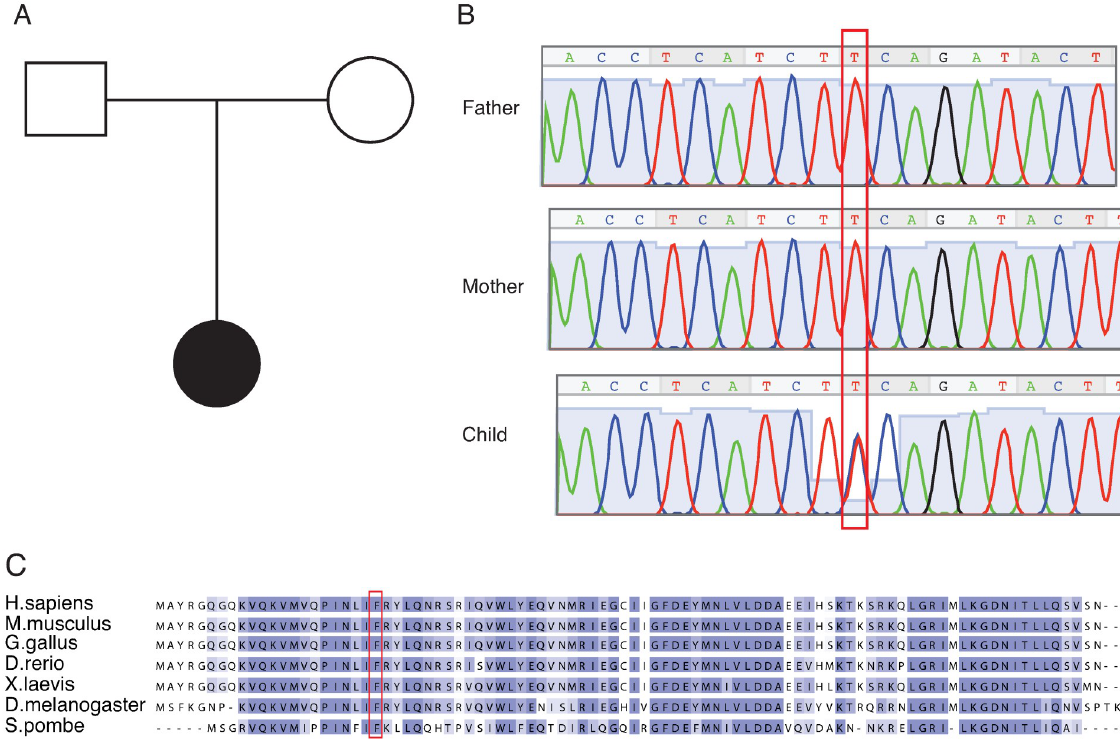
Fig 1. Identification of potential causative mutation by whole exome sequencing. (A), Family pedigree. Filled symbol indicates individual suffering from non-syndromal primary microcephaly and intellectual disability. (B), Traditional Sanger sequencing validated the identified SNRPE/SmE mutation (c.65T > C (p.Phe22Ser)). The red box labels the de novo heterozygous mutation. (C), Alignment of SNRPE/SmE protein sequences across different species. The red rectangle indicates the mutated residue.